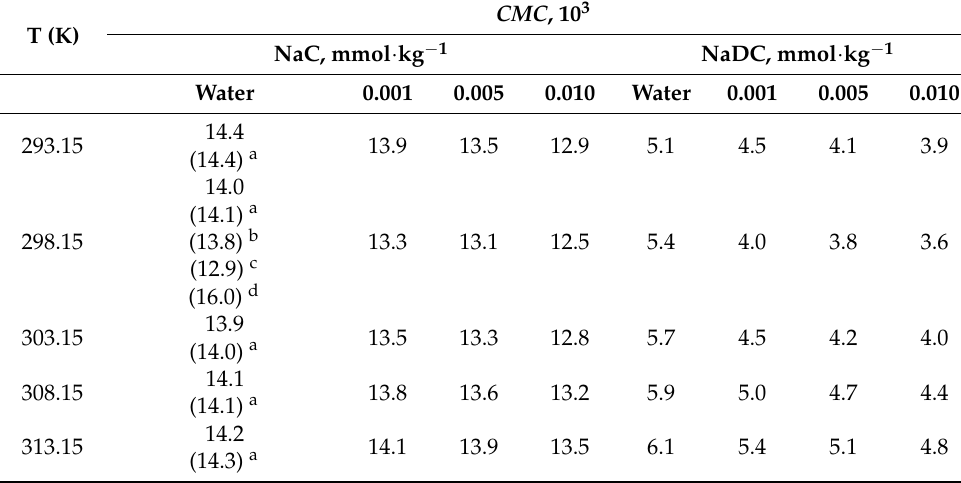
Table 2. CMC values of bile salts in studied concentration of aqueous glycyl dipeptide at various temperatures and experimental pressure, p = 0.1